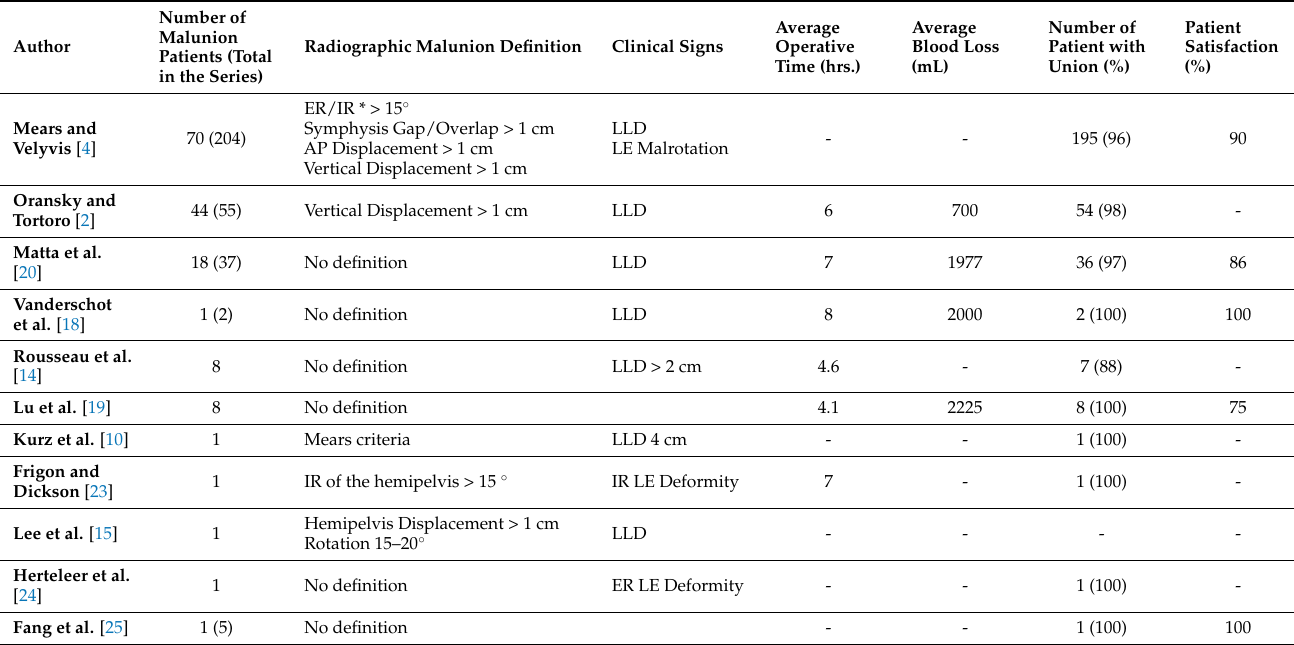
Table 1. Malunion definitions, clinical signs, reported surgical times and